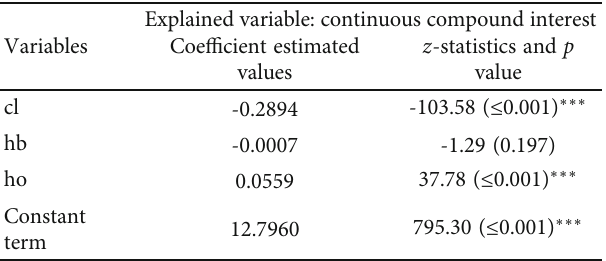
Table 4: The in fl uencing results of credit factors on continuous compound interest.